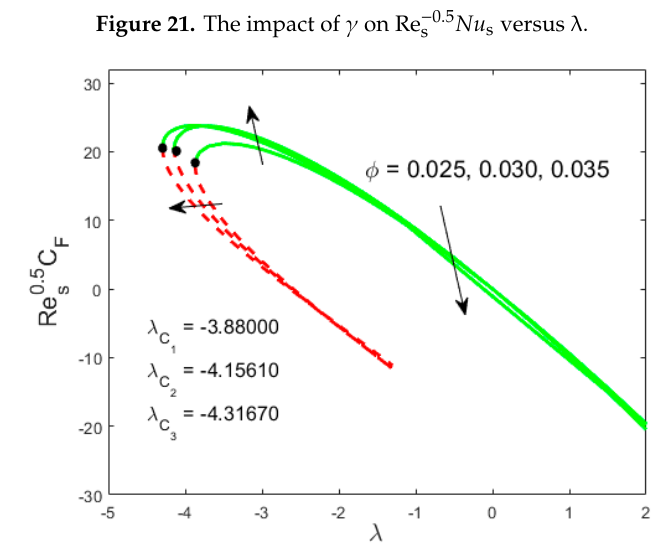
φ 0.5 Re C versus λ . on F s